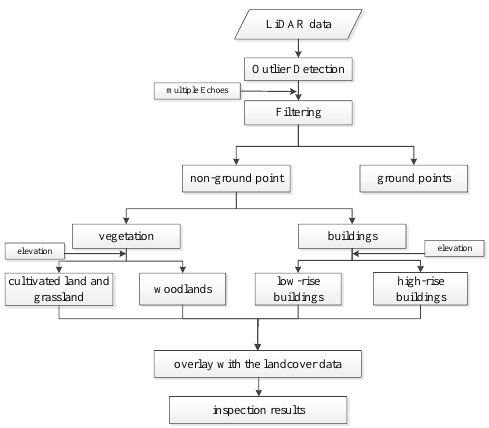
Figure 1. The flowchart of the quality inspection of land cover with LiDAR